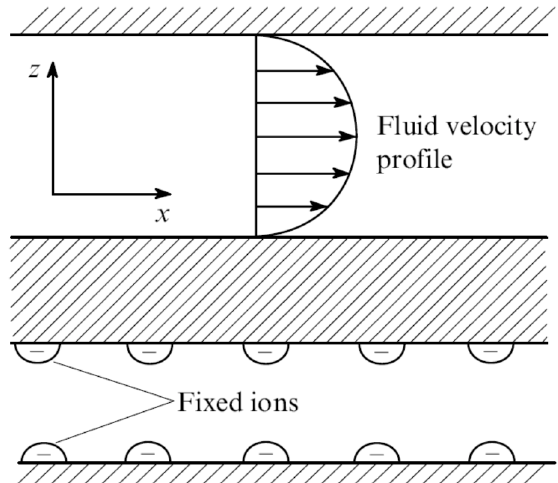
Figure 7. Schematic depiction of the membrane structure fragment containing pores with charged walls. The polymer matrix is presented by the hatched area. Reproduced with permission from [4], Wiley, 2012.